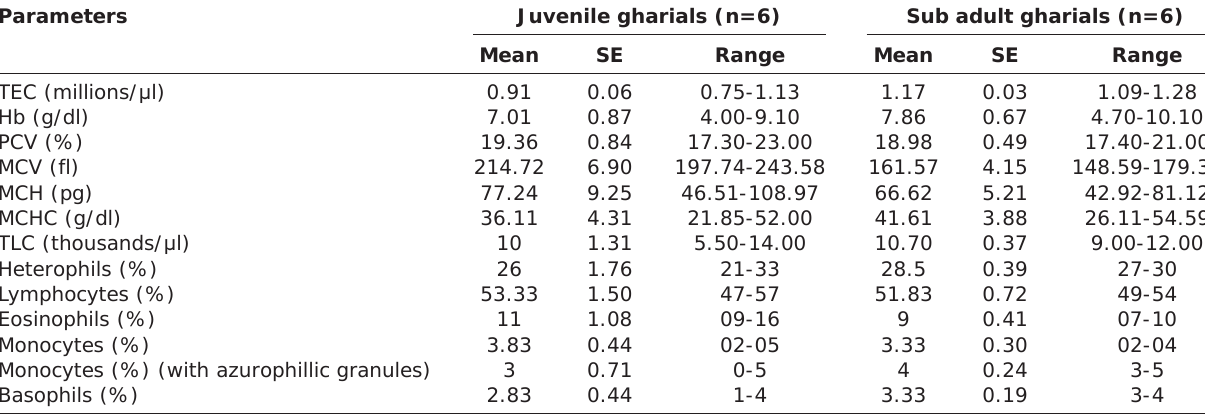
Table-1: Hematological values of juvenile and sub adult gharials ( G. gangeticus ). Parameters